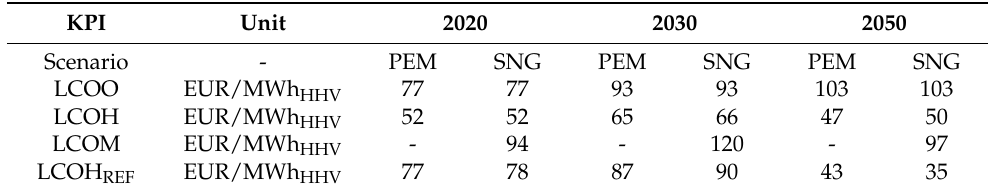
Table 8. Comparison of the levelized cost of oxygen, hydrogen, SNG, and the reference